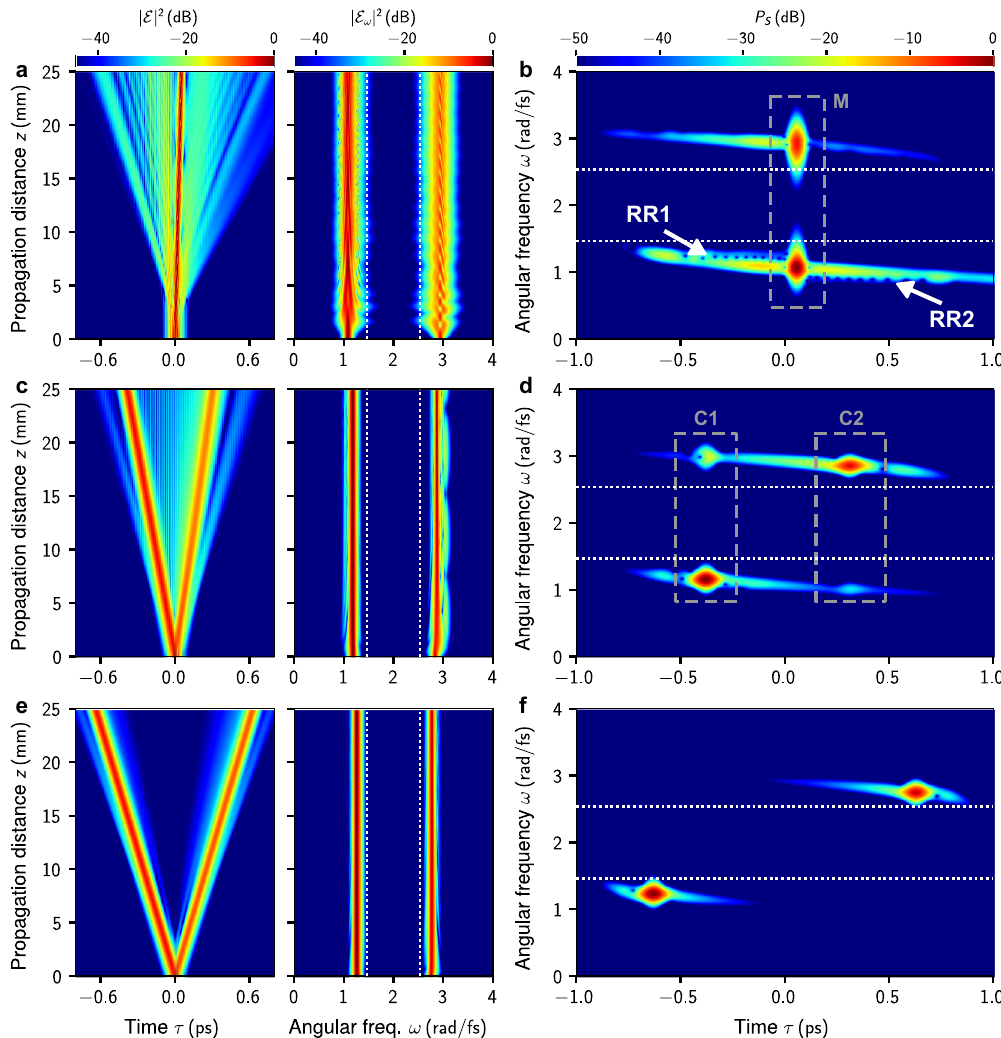
Figure 2. Exemplary propagation dynamics. ( a ) Evolution of the normalized time-domain intensity 2 / max 2 E ( z , t ) E ( z 0 mm, t ) and normalized spectral intensity | | [| = | ] 0 rad / fs . Vertical dashed lines indicate zero dispersion points. ( b ) Analytic signal analytic signal for �ω = 25mm for �ω 0 rad / fs . Horizontal dashed lines indicate zero dispersion points. Dashed spectrogram at z = = box (labeled M) encloses a molecule-like compound state. Trains of nodes signaling generation of resonant radiation are labeled RR1 and RR2. ( c , d ) Same as ( a , b ) for �ω (labeled C1 and C2) enclose pulse compounds each characterized by a strong trapping pulse and a weak trapped 0.18rad / fs . Spectrograms are computed using σ pulse. ( e , f ) same as ( a , b ) for �ω = −